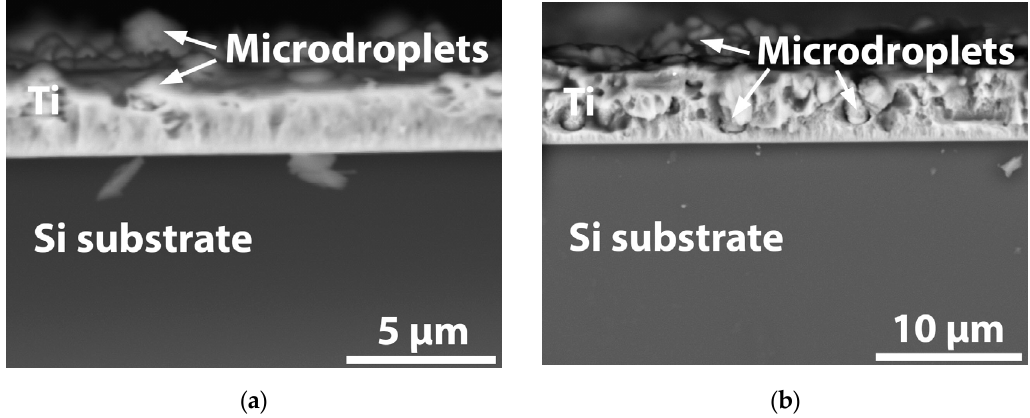
Figure 1. Typical scanning electron microscopy (SEM) images of the Ti coatings deposited on Si substrates during test deposition: Mode 1 ( a ) and mode 2 ( b ).